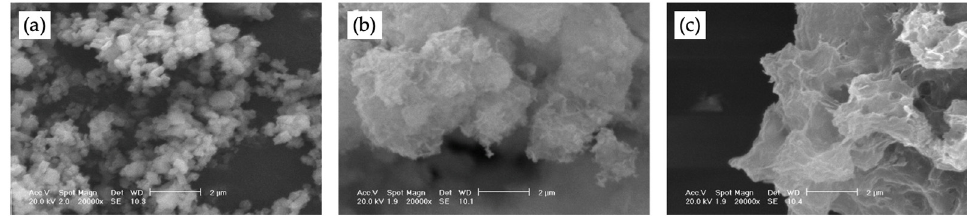
Figure 5. SEM images of nCH/NP mixtures at different hydration times: ( a ) after 30 min; ( b ) after 28 days, considering a nCH/NP ratio of 1:1; ( c ) after 28 days, considering a nCH/NP ratio of 1:2. Scale bar: 2 μ